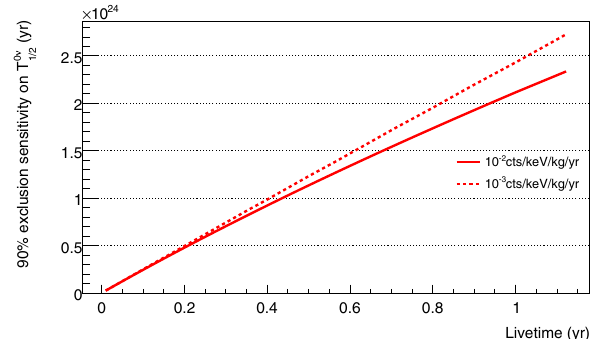
Fig. 18 Bayesian exclusion sensitivity at 90%CI for 5keV resolution (FWHM) at Q ββ and different background